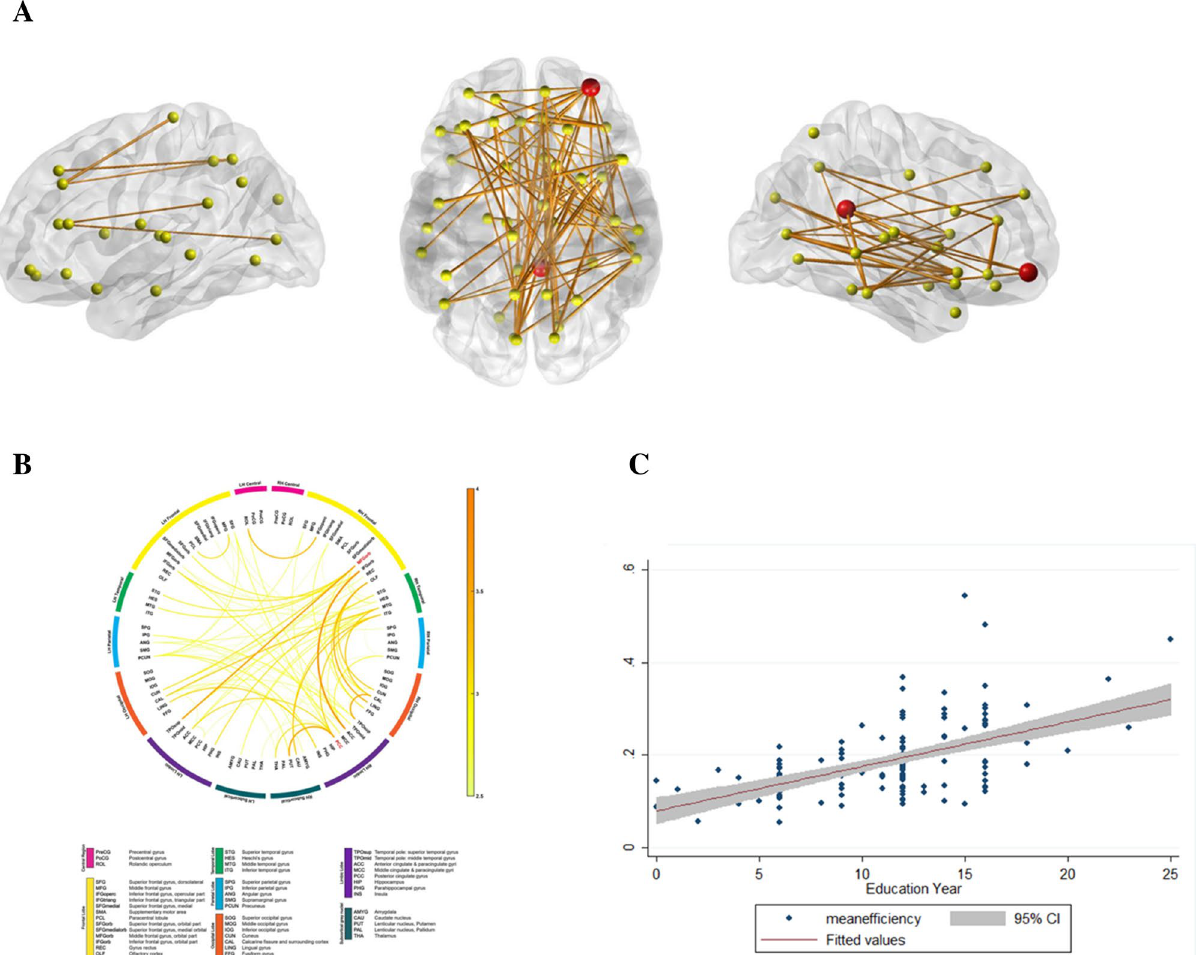
Figure 1. ( A ) In the late aMCI group, a sub-network showed a positive correlation between years of education and RSFN edge efficiency. The red circles represent the hub regions, which are located in the orbital part of the right middle frontal gyrus (MFGorb), and the right posterior cingulate gyrus (PCC). ( B ) Connectogram showing the sub-network. The thickness and colors represents the t-statistics computed from simple slope analyses. Hub regions are presented in red color. ( C ) Correlation between education and mean RSFN edge efficiency of the sub-network in the late aMCI group. aMCI amnestic mild cognitive